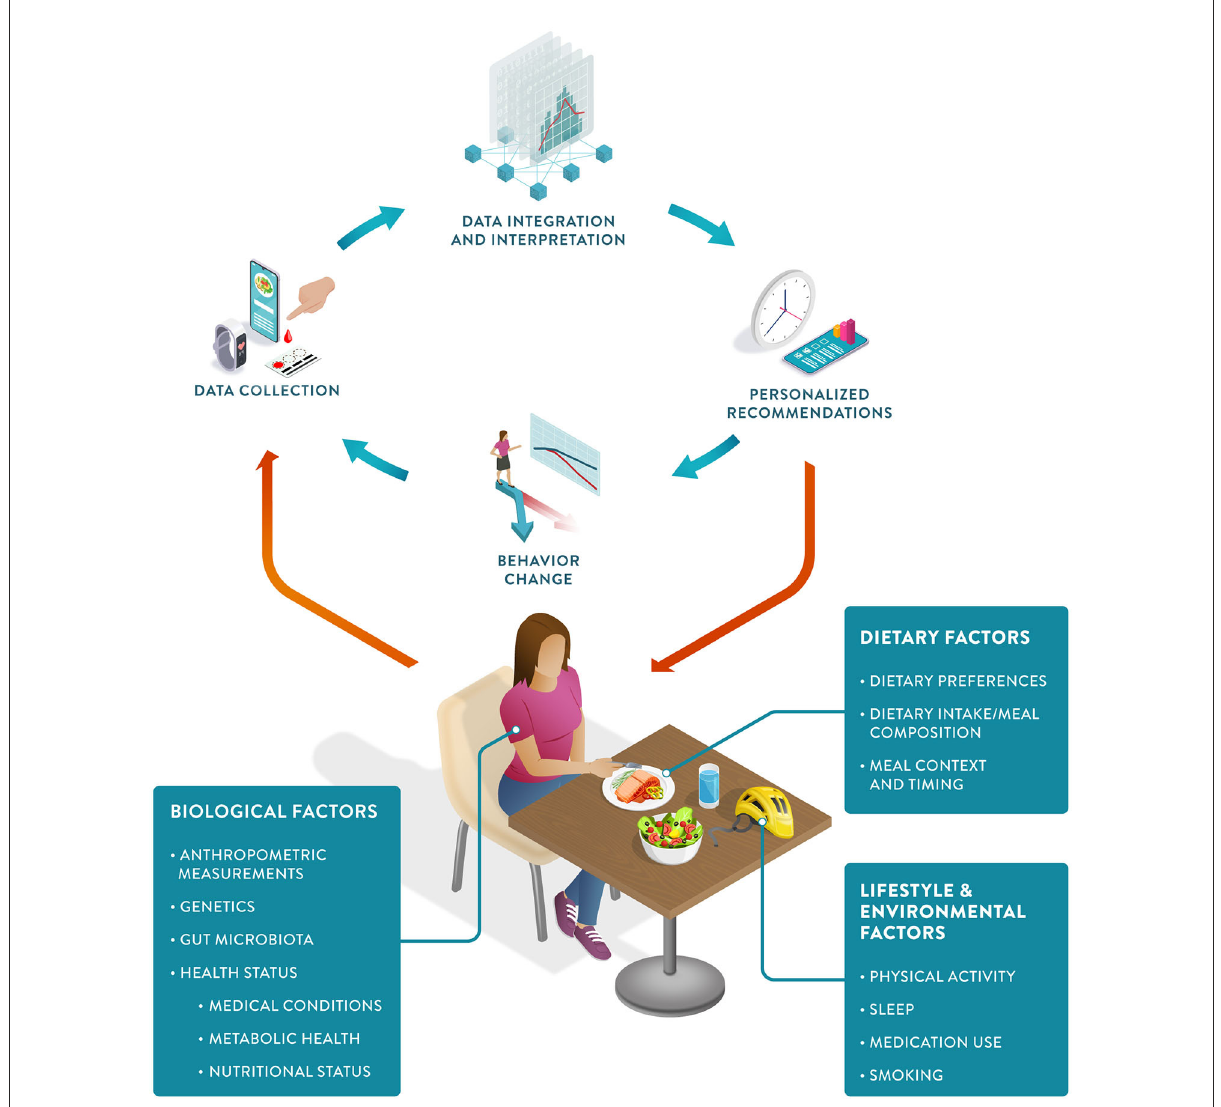
FIGURE1 The Precision Nutrition approach: The PN feedback loop starts with individual data collection, including biological, dietary, and other lifestyle factors. Data integration and interpretation enable personalized recommendations, which in turn can induce positive behavioral change, ultimately resulting in improved health outcomes.